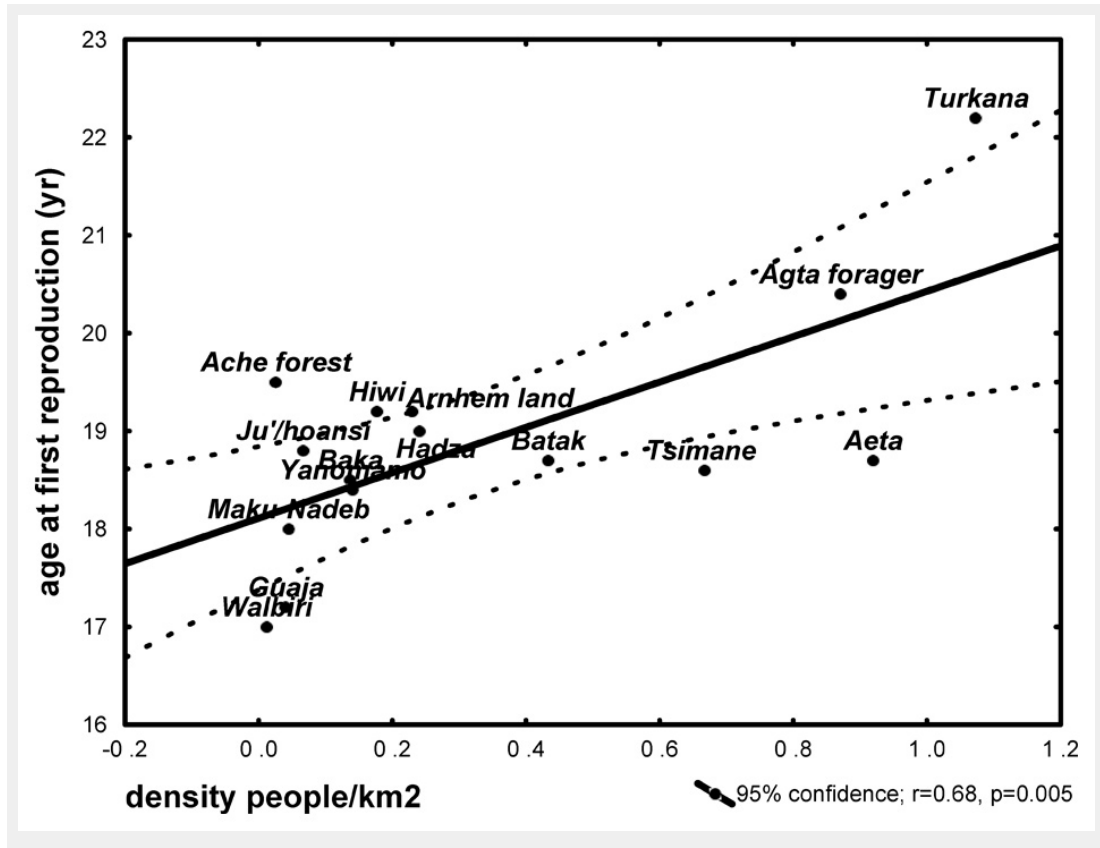
The regression line and the 95% confidence limits for the age of first reproduction as a function of density in traditional